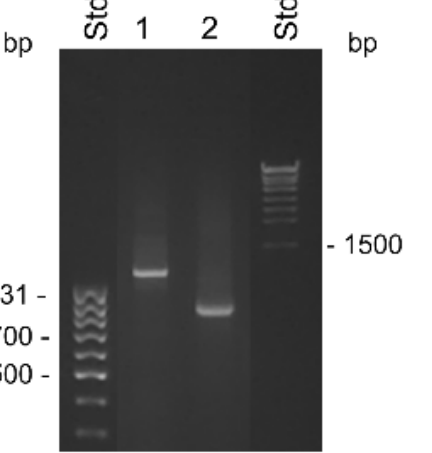
Figure 1. Detection of KLK4T2 by RACE. RACE products generated from 2 ng unfractionated LNCaP cell RNA were analyzed by electrophoresis on 1% agarose gel. Lane 1 shows 5′ RACE with the specific primer KLKP9R and lane 2 shows 3′ RACE with the specific primer KLKP8F. For information about the primer sequences, see Table 1. MassRuler Low Range (Std L) and High Range (Std H) were used as molecular size markers. Relevant sizes in bp are indicated in the figure.